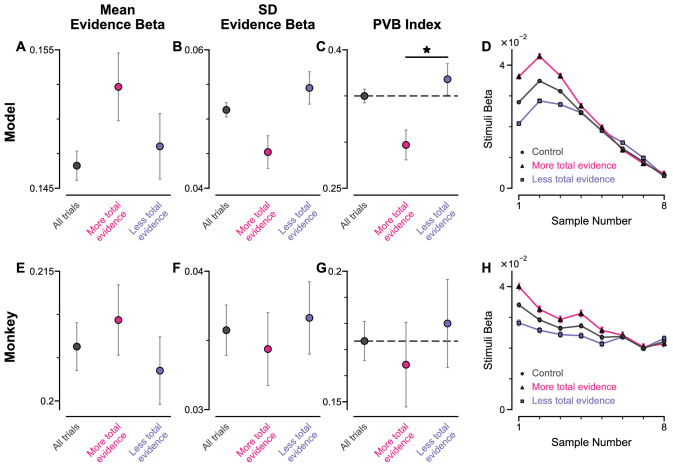
Pro-variance bias and temporal weightings in trials separated with more or less total evidence, for circuit model and monkey data.(A–C) Regression analysis of the circuit model choices, using evidence mean and variability as predictors, on all regular trials (grey), half of the regular trials with more total evidence (pink), and half of the regular trials with less total evidence (blue). (A) Regression coefficient for mean evidence. The regression coefficient for mean evidence is not significantly different between trials with more total evidence and trials with less total evidence (permutation test, p=0.8366). (B) Regression coefficient for evidence standard deviation. The regression coefficient for evidence standard deviation is not significantly different between trials with more total evidence and trials with less total evidence (permutation test, p=0.8710). (C) PVB index. The PVB index is significantly higher for trials with less total evidence than for trials with more total evidence (permutation test, p=7×10−5) (D) Temporal regression weights using the three sets of trials. (E–H) Same as (A–D) but using the monkey behavioural data. The regression coefficients for mean evidence and evidence standard deviation are not significantly different between trials with more total evidence and trials with less total evidence (permutation tests, p(mean evidence)=0.9452, p(evidence standard deviation)=0.9869). The PVB index tends to be higher for trials with less total evidence than for trials with more total evidence, but the effect is insignificant (permutation test, p=0.3677). All errorbars indicate the standard error.